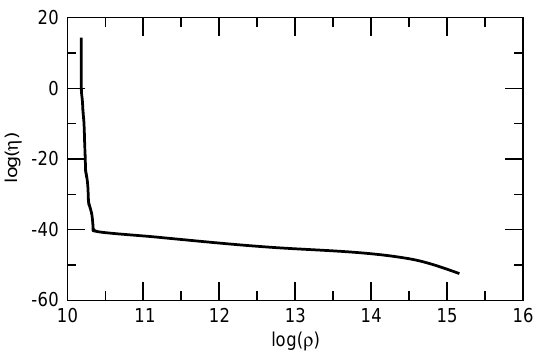
Fig. 2. An example of the L-curve used in this study. This particular curve pertains to the last ClO measurement after the transformation of the cost function into standard form. In this figure η refers to the norm of the transformed state vector and ρ to the norm of the transformed least squares term. The regularisation parameter corre- sponding to the lower left corner is used to determine the retrieved state vector.